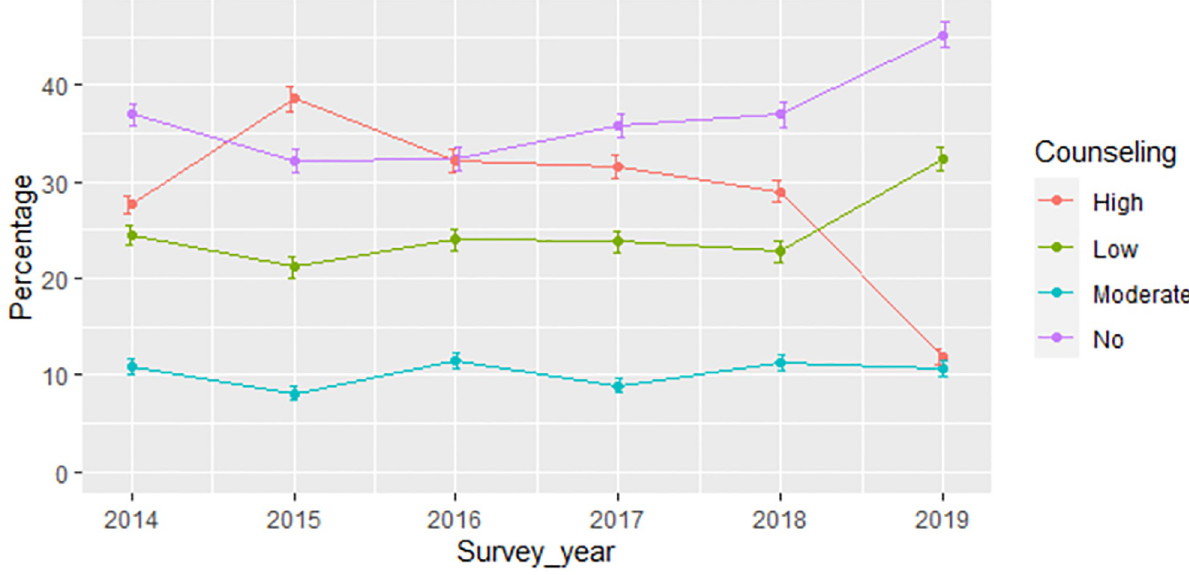
Fig 1. Percentage of women receiving different levels of family planning counseling service over survey years.